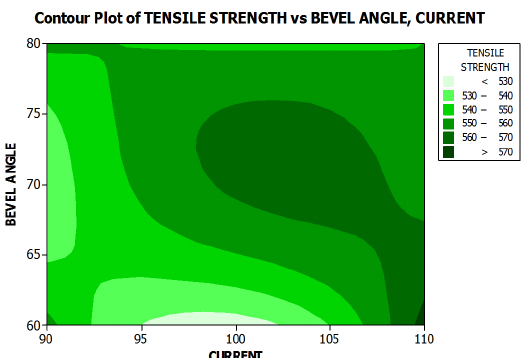
Figure 4. Contour plot of Tensile strength vs Bevel angle, current.